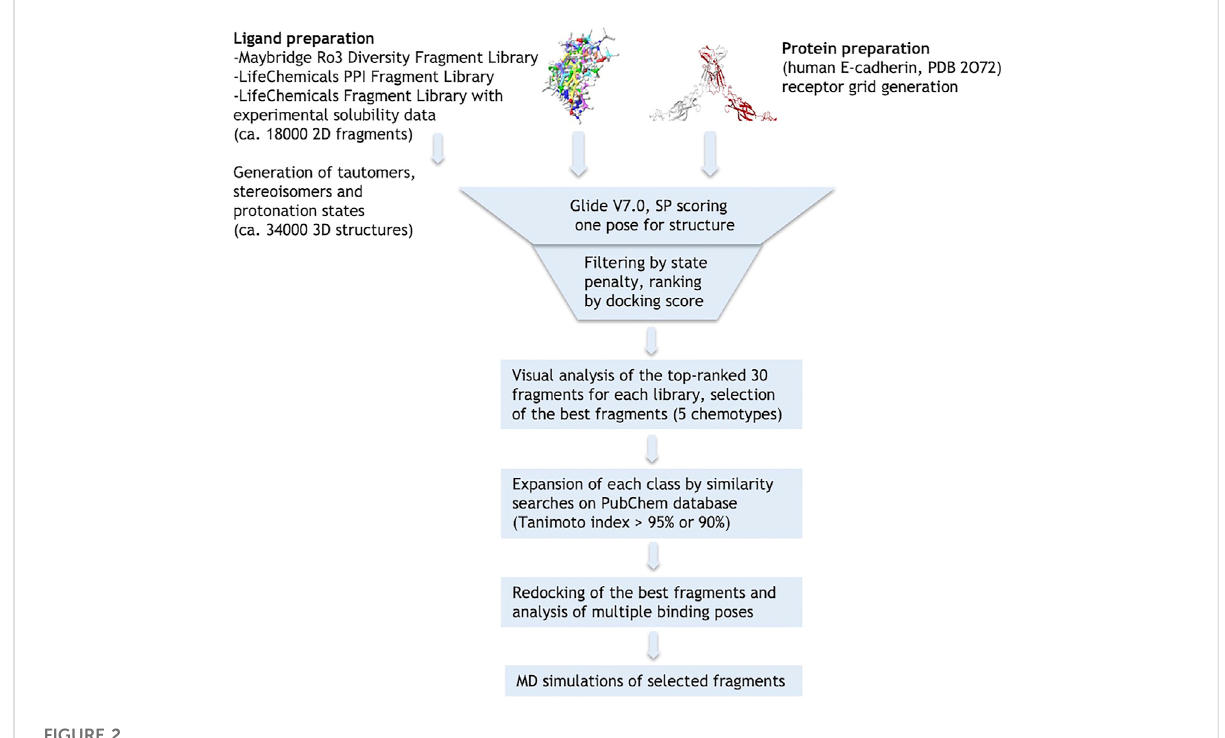
FIGURE 2 Schematic representation of the virtual screening work fl